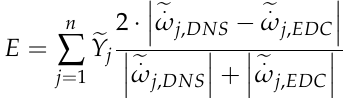
(cid:3099) at 𝐶 (cid:3099) = 1 .